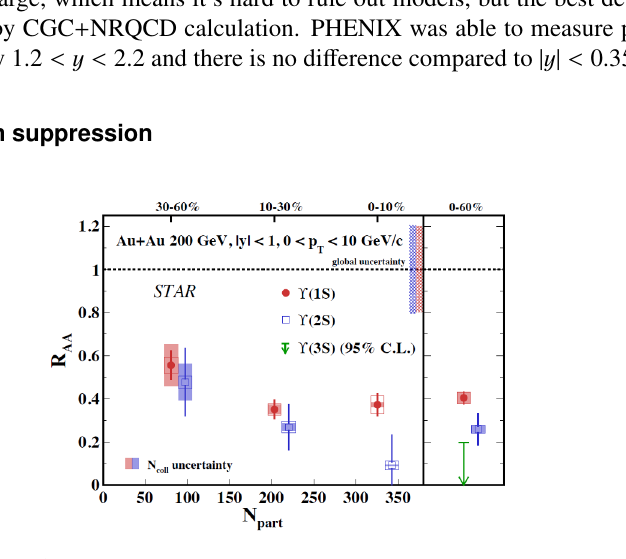
Figure 5: Nuclear modification factor of Υ states vs. N part